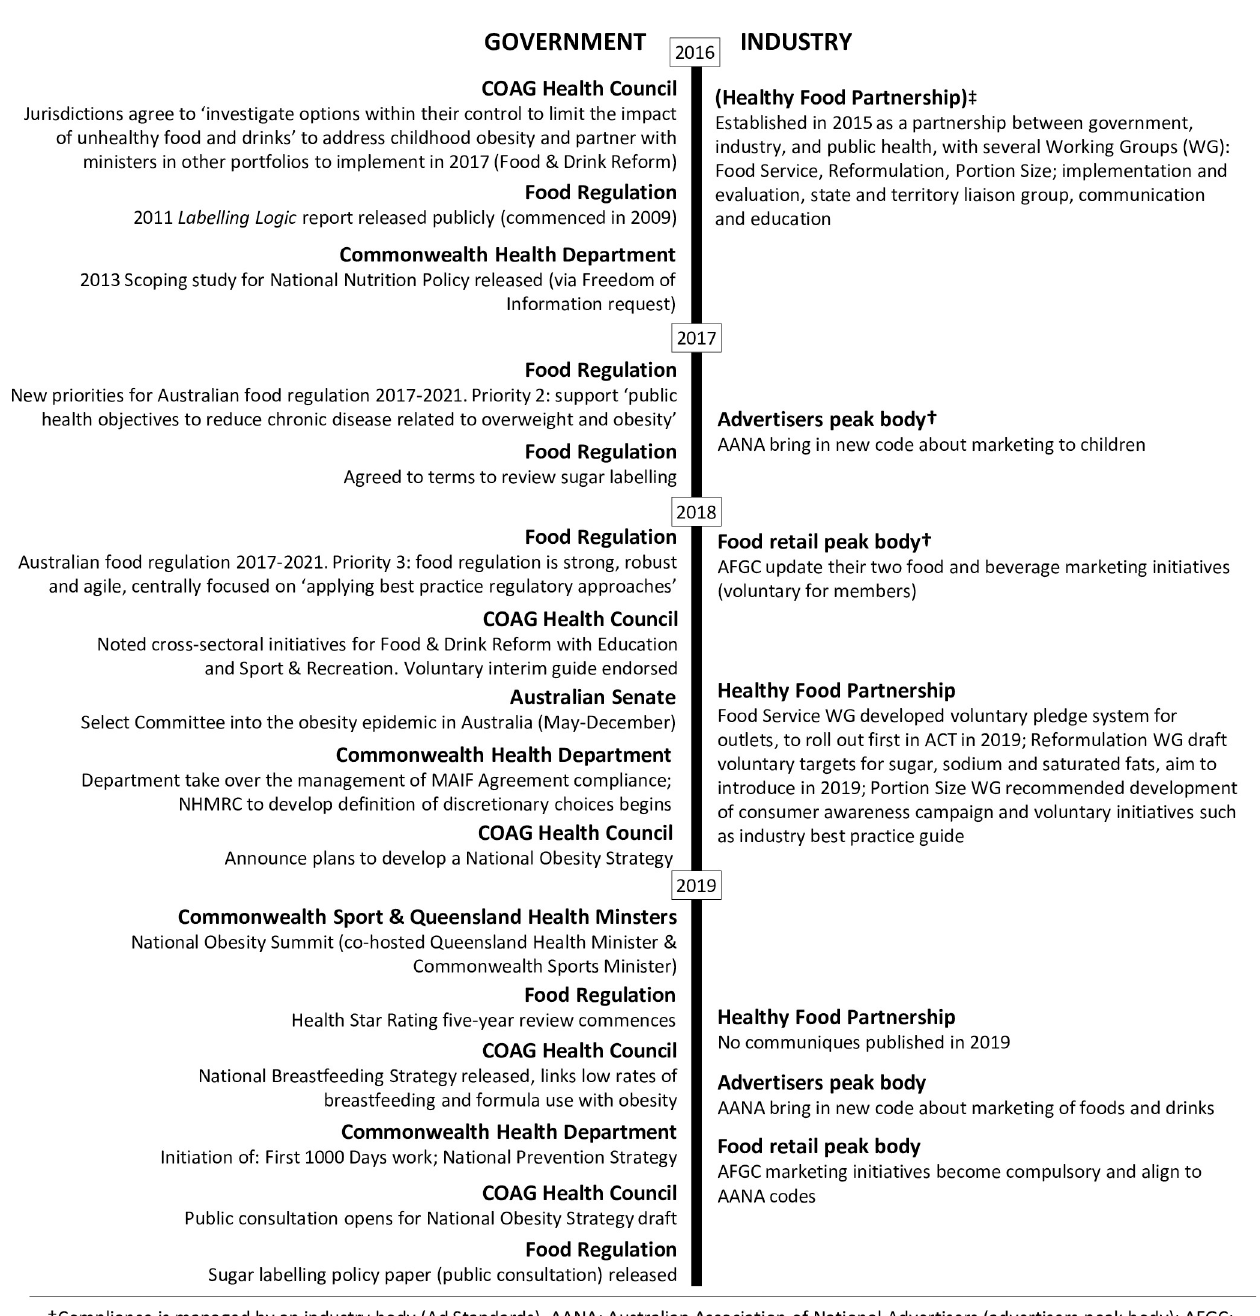
Fig 2. Timeline of recent national obesity prevention